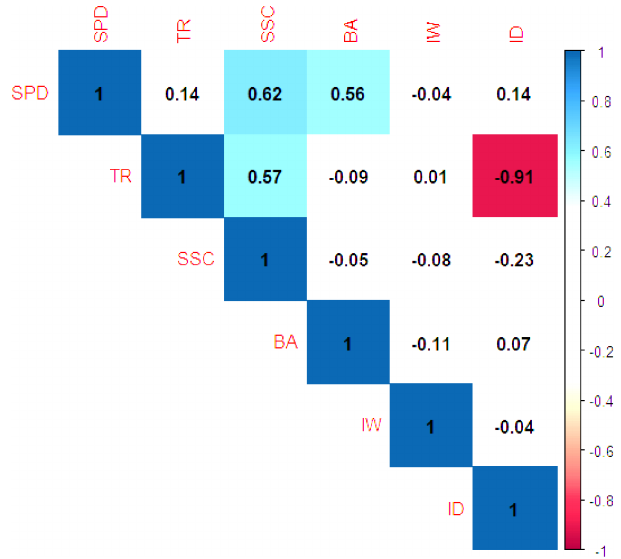
Table 4. Pearson correlation coefficients between sediment deposi- tion per day (SPD), tidal range (TR), suspended sediment concen- tration (SSC), beel surface area (BA), width of the inlet (IW), and inundation depth